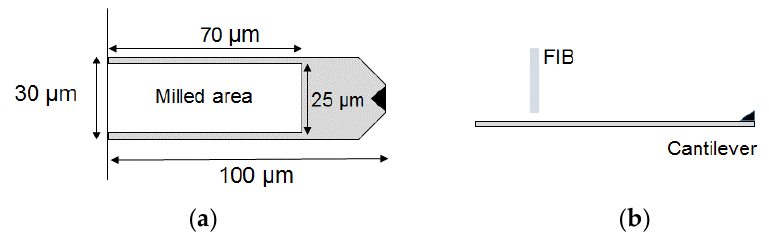
Figure 6. Schematic diagram of focused ion beam (FIB) processing of the cantilever: ( a ) Dimensions of the processing area; ( b ) positional relationship between the FIB and the cantilever.